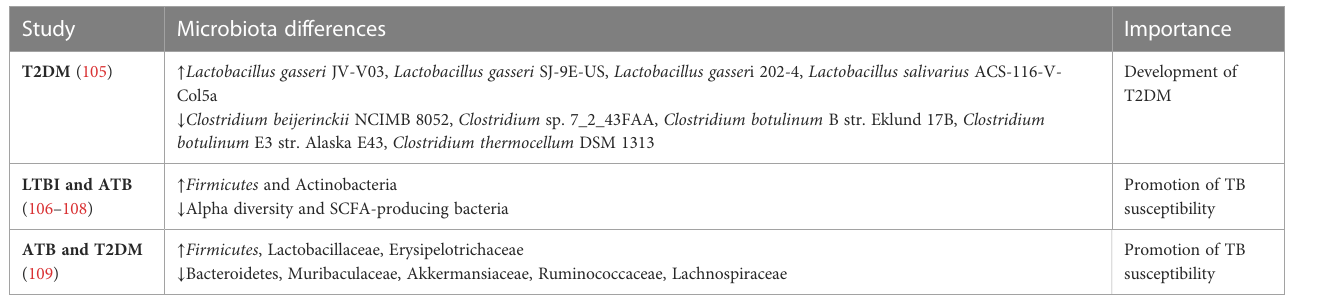
TABLE 1 In fl uence of gut microbiota in the TB and T2DM